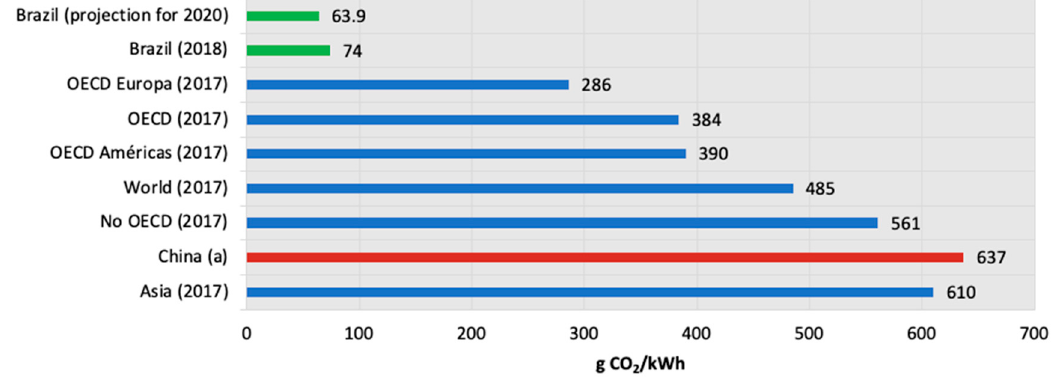
Figure 3. Average electricity emission factors for the period 2015–2018. Data Source: [9–11]. Note: (a) the average value of the IEA in the years 2015 and 2017 [9].